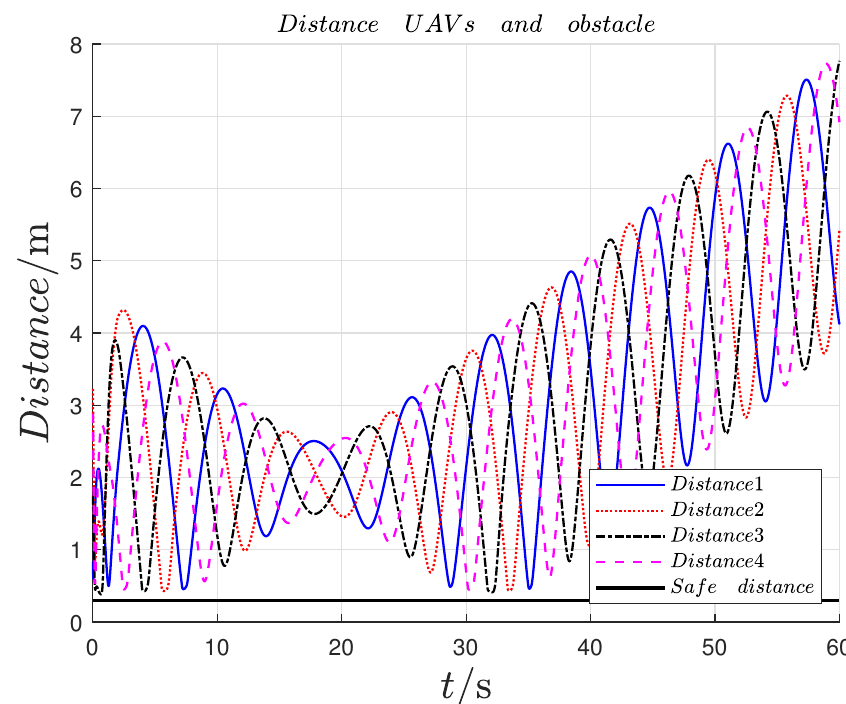
Figure 6. Relative distances of UAVs.